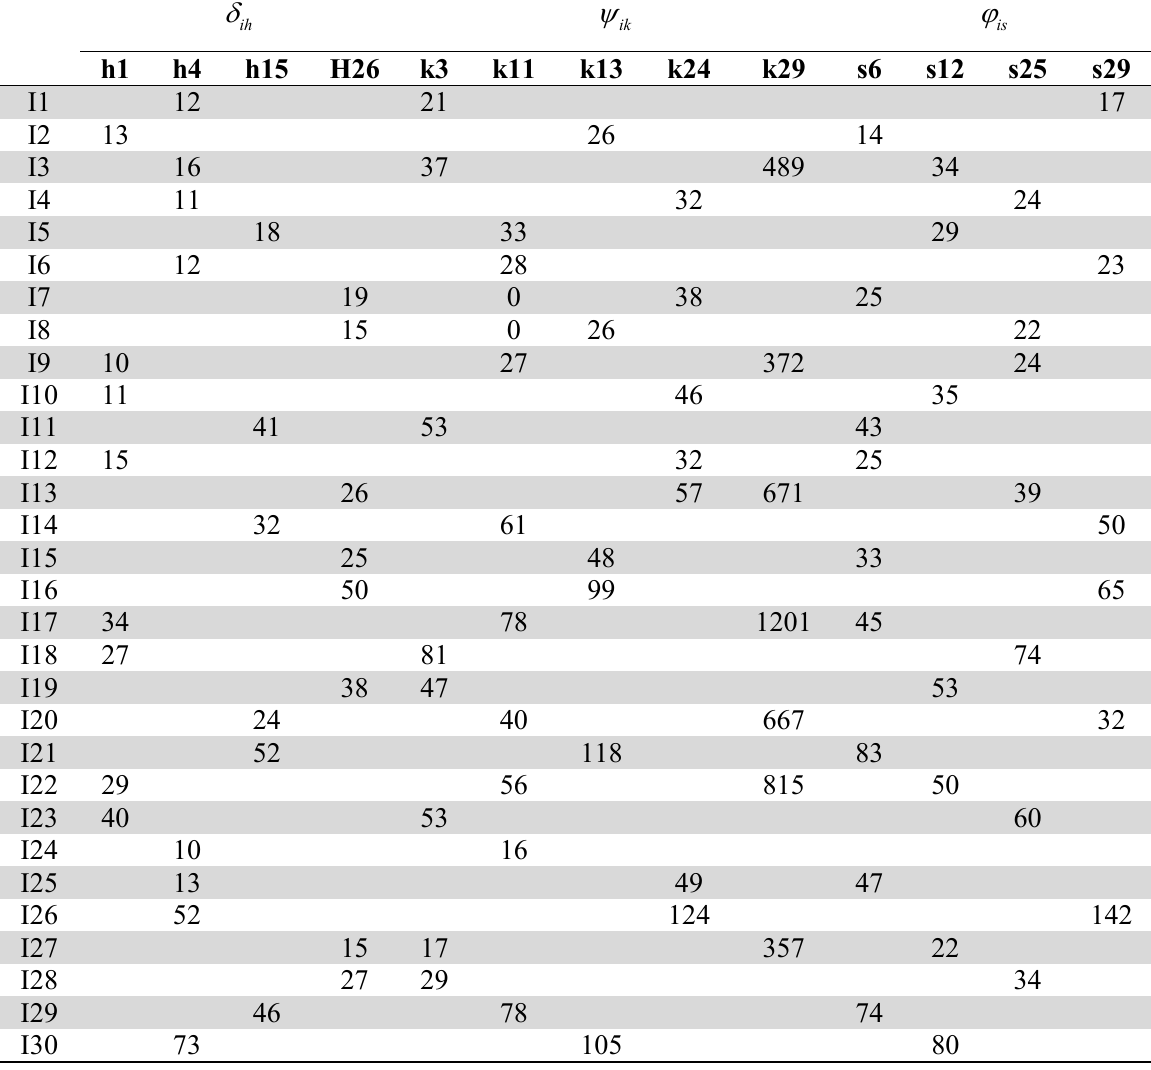
Results of model implementation